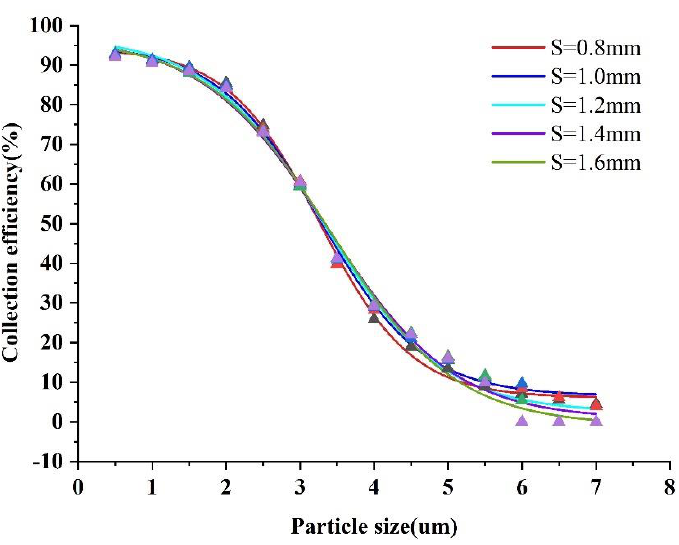
Figure 8. Collection efficiency curves at different S values.